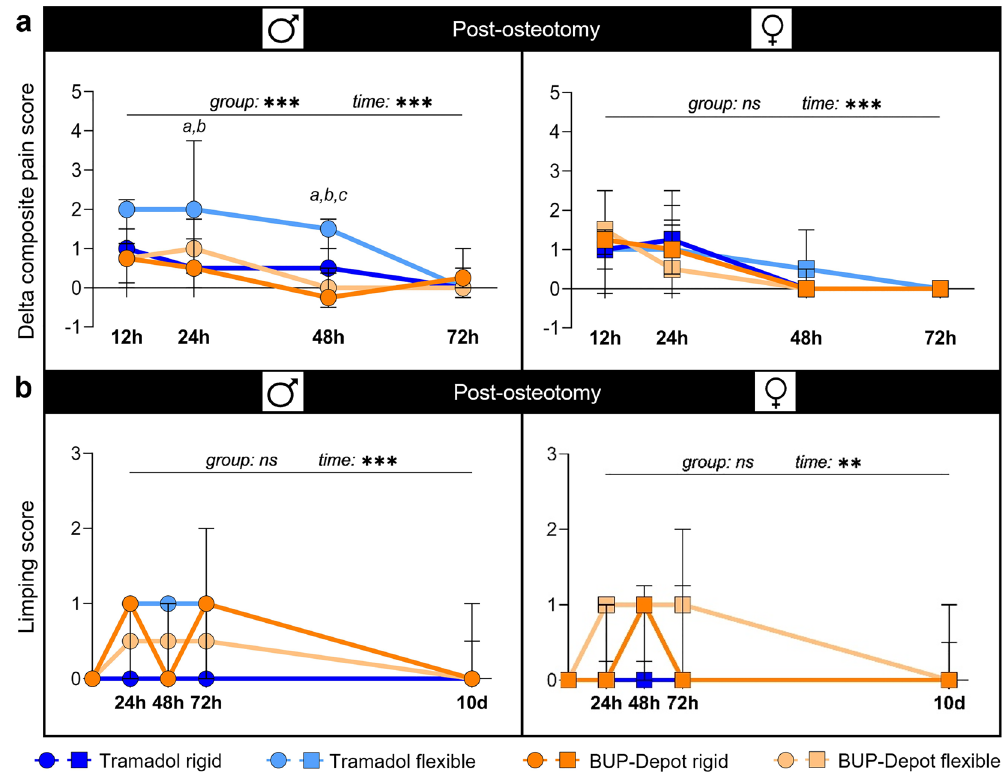
Table S10). Male mice with flexible fixation and Tramadol treatment also showed shortened stride length which was significant at 24 h compared to the BUP-Depot rigid group (non-parametric ANOVA-type test p =